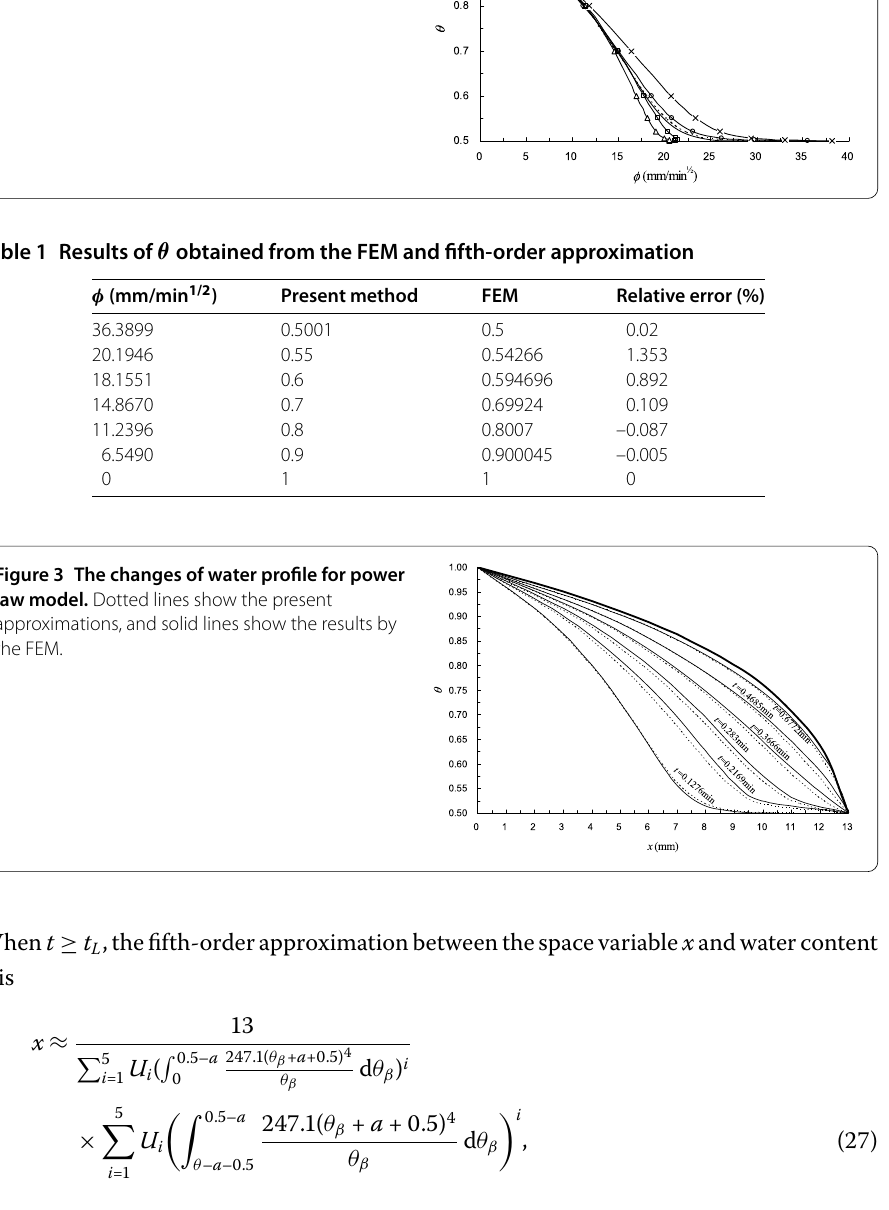
Figure 2 Results of φ obtained from the FEM and approximations of orders 1-5.